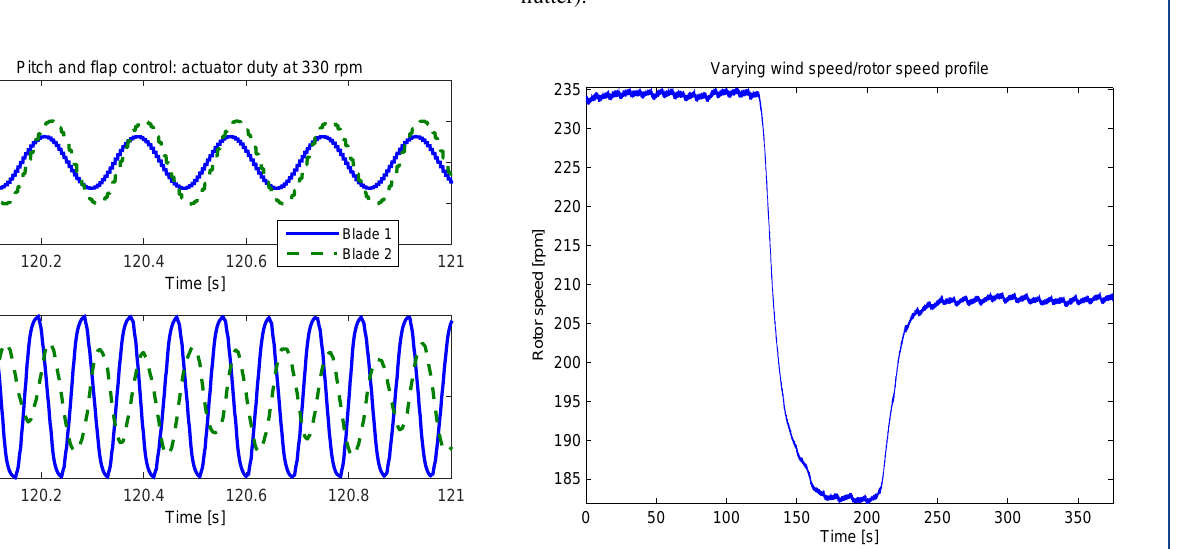
Figure 20. Load reductions achieved by optimised controller (post- flutter).